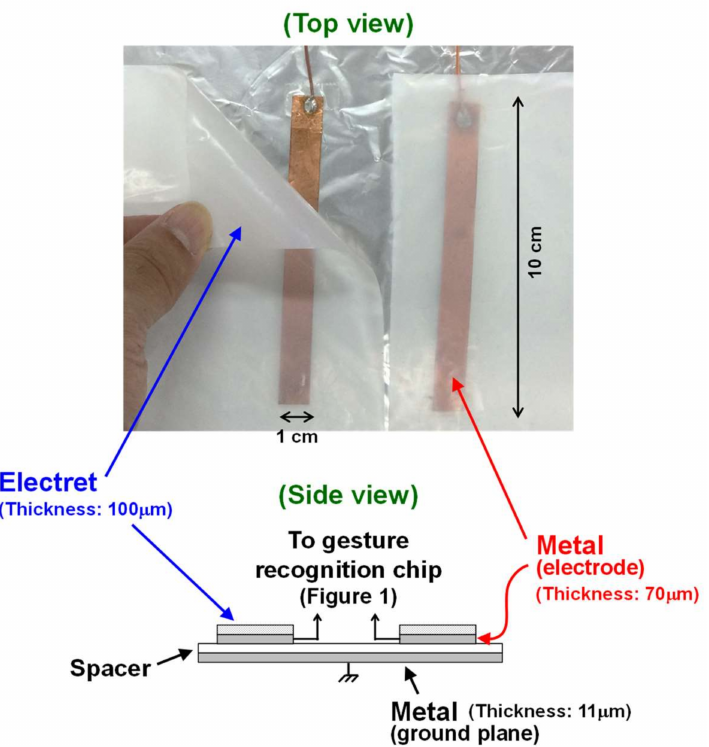
Figure 2. Photograph and cross-sectional view of the sensing electrodes used in this study. Two electrodes are used to recognize hand gesture. Each electrode consists of an electret foil stacked on a metal